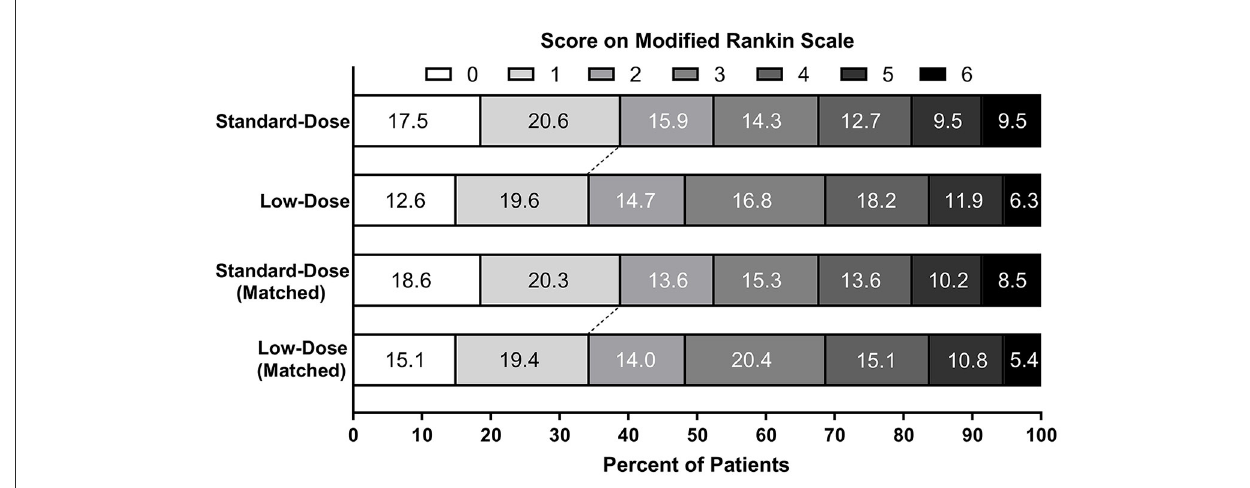
FIGURE2 Distribution of scores on the modified Rankin Scale at 90 days before and after